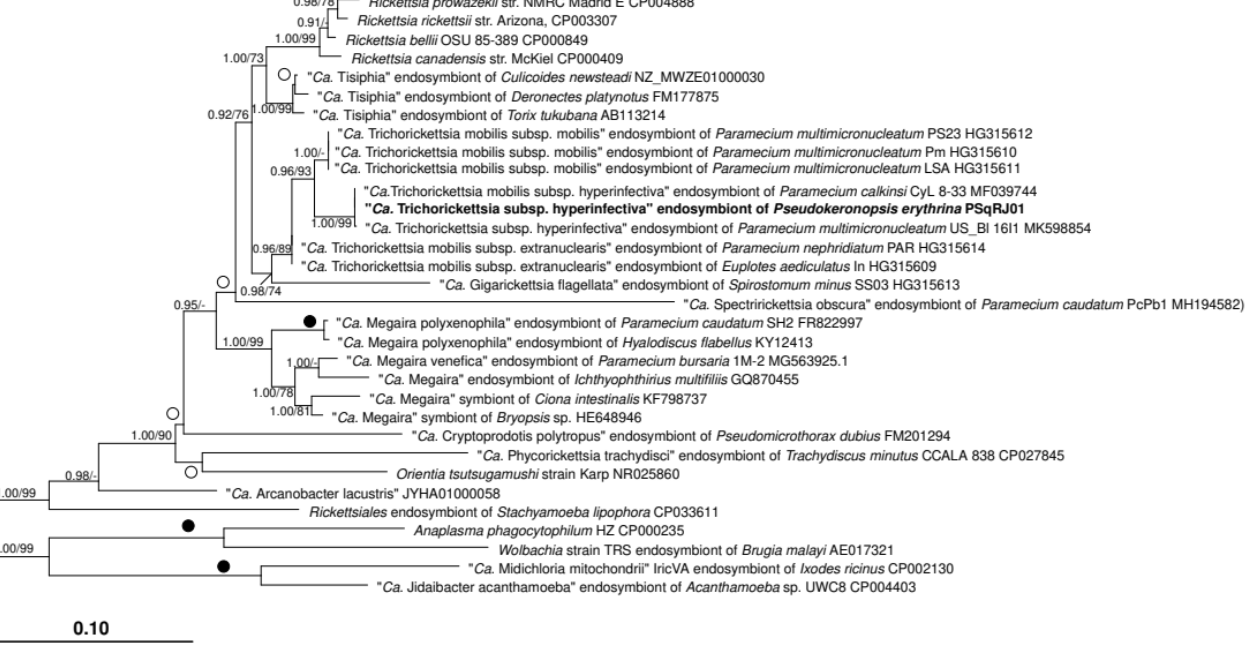
Table 1. Percent identity values of the 16S rRNA genes of “ Ca . Trichorickettsia” on the “full- sequence” matrix (1360 nucleotide positions). The newly characterized sequence of the endosymbiont of Pseudokeronopsis cfr. erythrina PSqRJ01 is highlighted in bold. Full identity values are highlighted in bold.